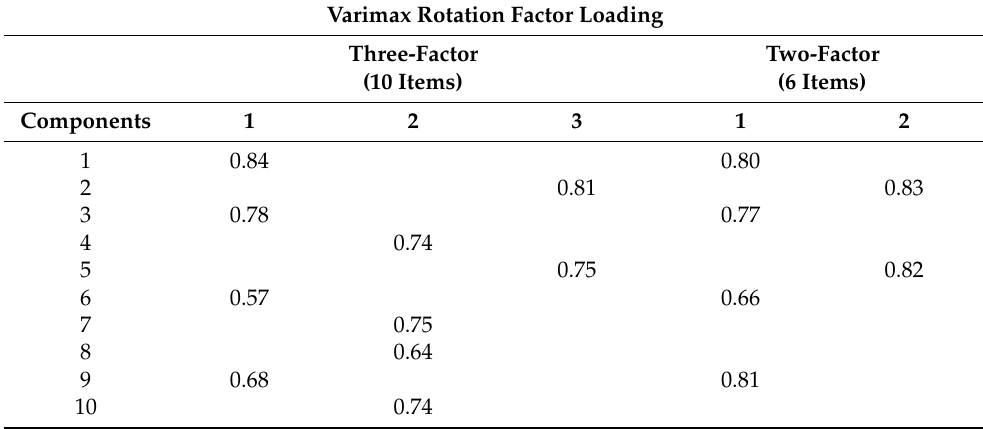
Table 5. Value of Varimax rotation factor loading of the FAS a.